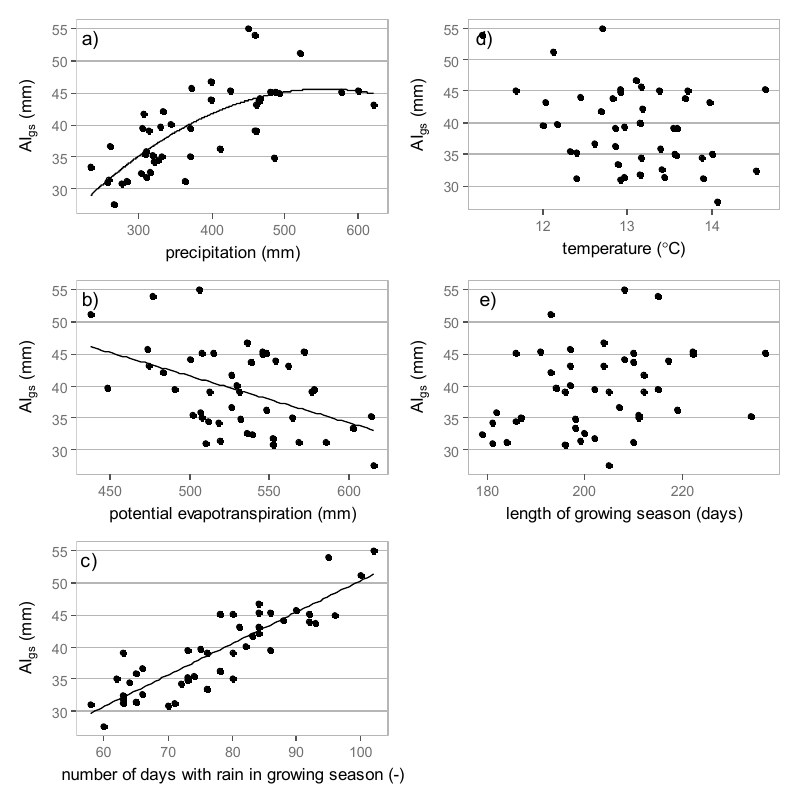
Figure 6 . Relationship between absolute growing season interception (AI gs ) and: ( a ) sum of precipitation; ( b ) sum of potential evapotranspiration; ( c ) number of days with rain; ( d ) mean temperature; ( e ) length of the growing season.